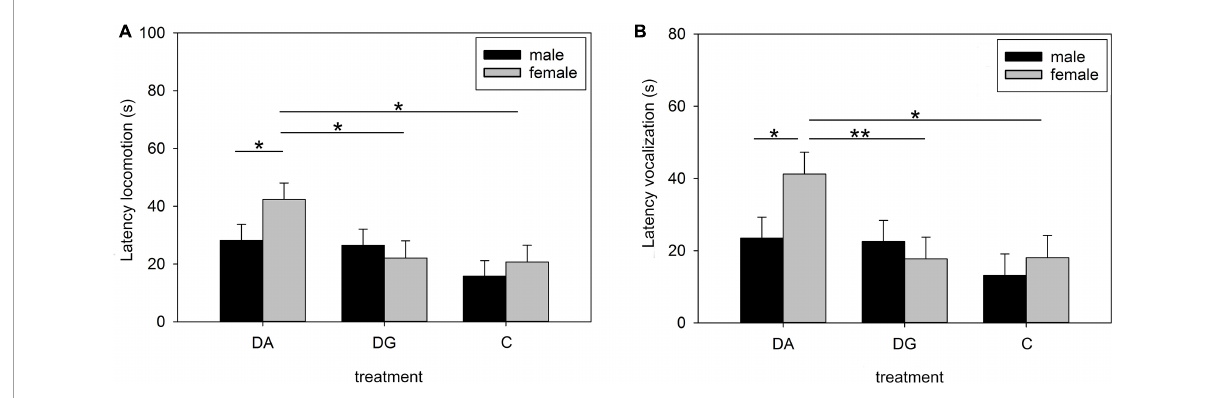
FIGURE4 Behavior in the open-field/novel-object test on PND 16. Latency of locomotion (A) and vocalization (B) of male and female pigs of the three treatment groups DA (deprivation alone), DG (deprivation in a group with littermates), and C (control, no deprivation). Results are presented as LSM ± SE. Significant differences (Tukey-Kramer test) are indicated with asterisks (* p < 0.05; ** p < 0.01; n = 24–33 per treatment group and